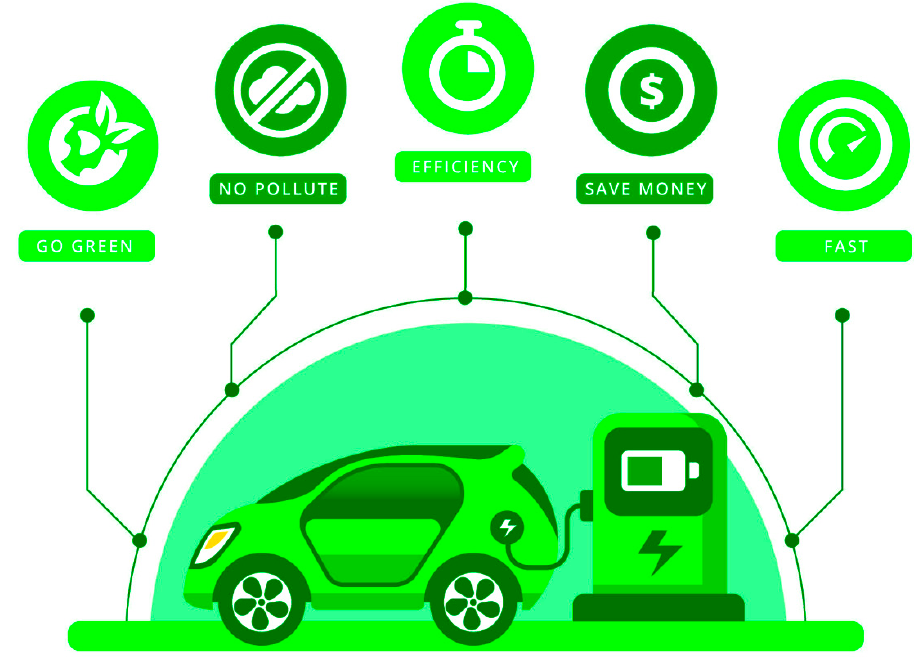
Figure 1. Several benefits of electric vehicles.